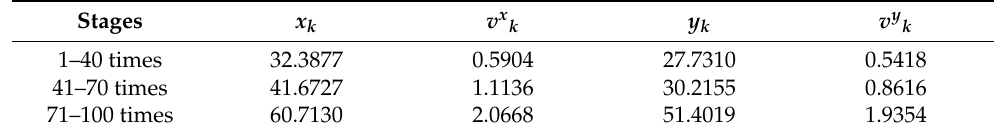
Table 3. RMSE with HUKF at different